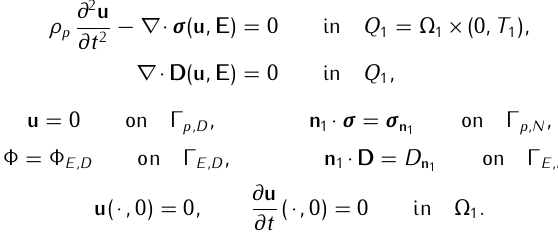
where ε is the electric permittivity of the material and P stands for the polarization which depends linearly on the displacement u according to P = e ε ( u ). We assume that the piezoelectric material with density ρ occupies some domain Ω 1 with boundary Γ 1 = ∂ Ω 1 and exterior unit normal n 1 such